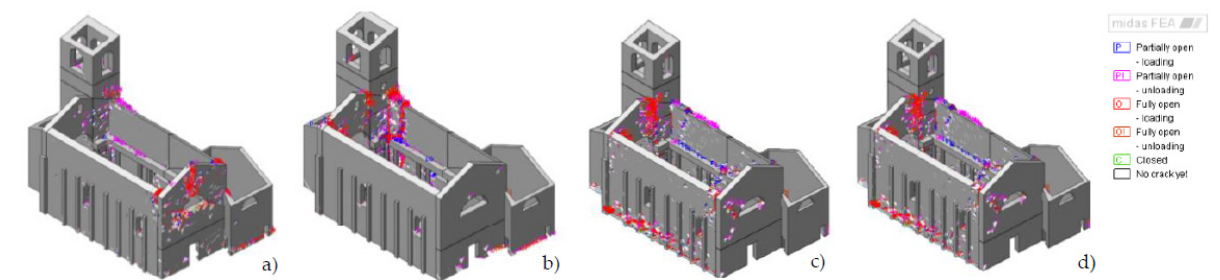
Figure 12. Numerical damage for San Francesco Church in Sarnano (Macerata, Central Italy) for PushMass + x ( a ), PushMass − x ( b ), PushMass + y ( c ), PushMass − y ( d ).